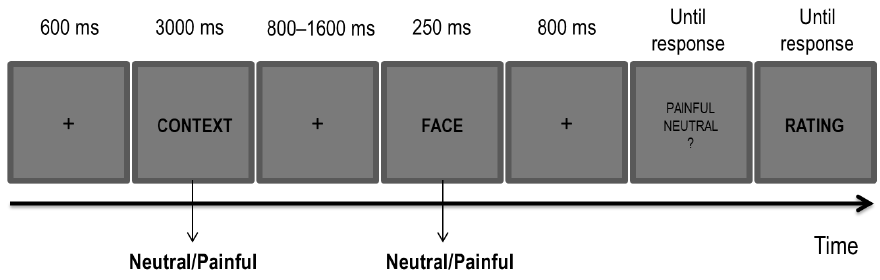
Figure 1. Experimental paradigm for the Empathy Task.